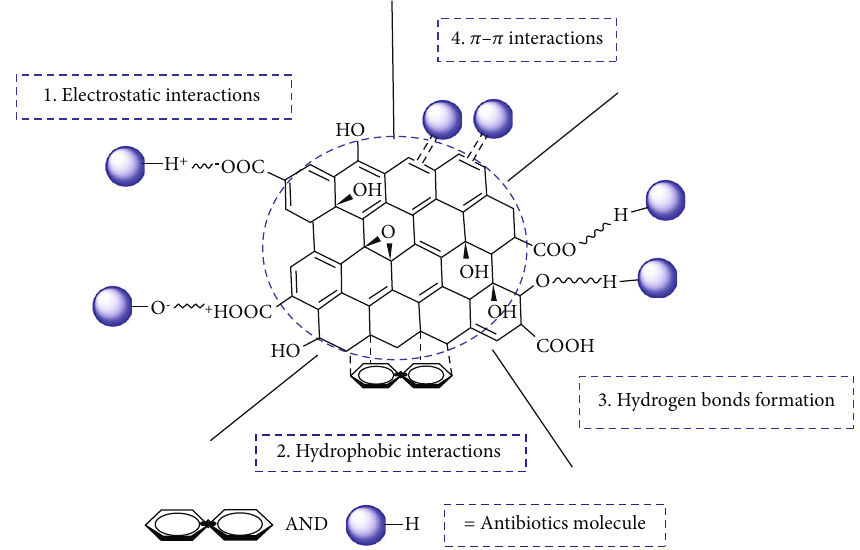
Figure 6: Adsorption mechanisms between carbon-based adsorbents and antibiotics. The types of adsorptive interaction include electrostatic interaction, hydrophobic interaction, hydrogen bond formation, and π − π